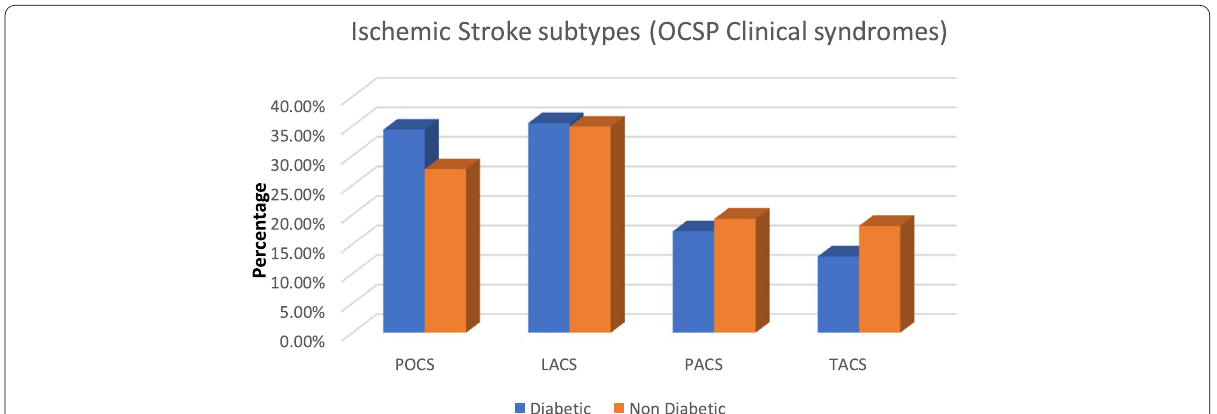
Fig. 2 Comparison between the two studied groups according to ischemic stroke subtypes (OCSP clinical syndromes). POCS, posterior circulation syndrome; LACS, lacunar syndrome; PACS, partial anterior circulation syndrome; TACS, total anterior circulation